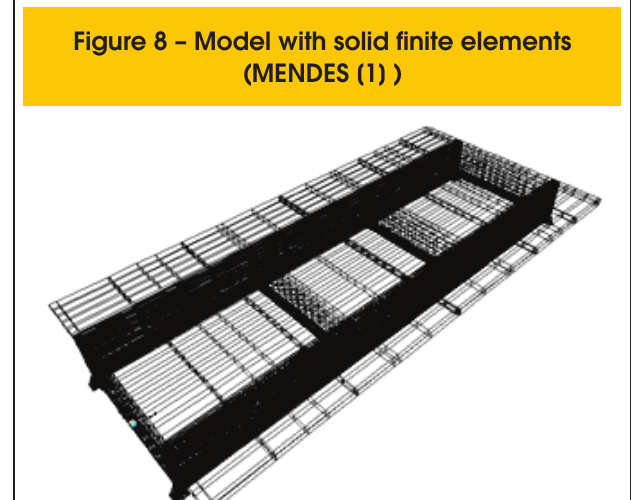
Figure 6. For analysis effect concrete with f mitted and reinforcement constituted of steel CA24 or CA50.